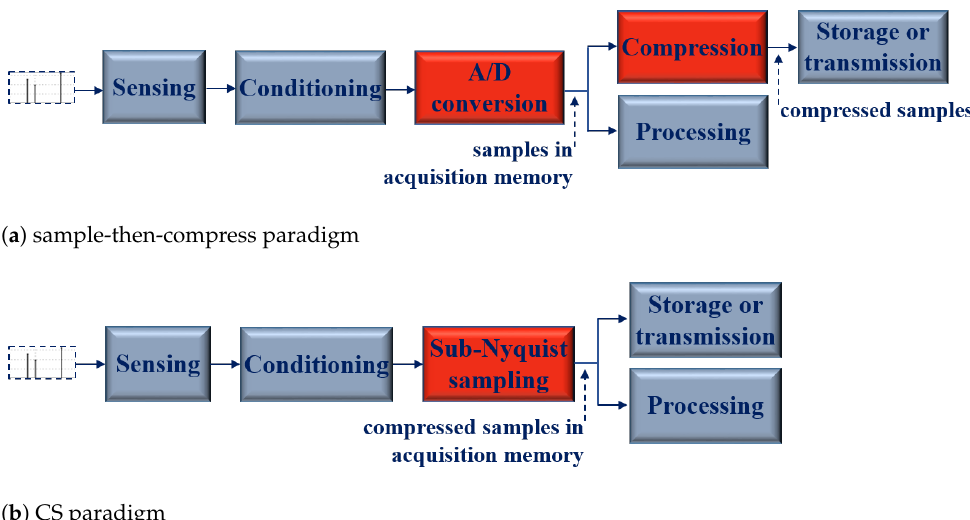
Figure 1. Comparison between the data acquisition systems implementing compression: ( a ) sample- then-compress paradigm and ( b ) CS